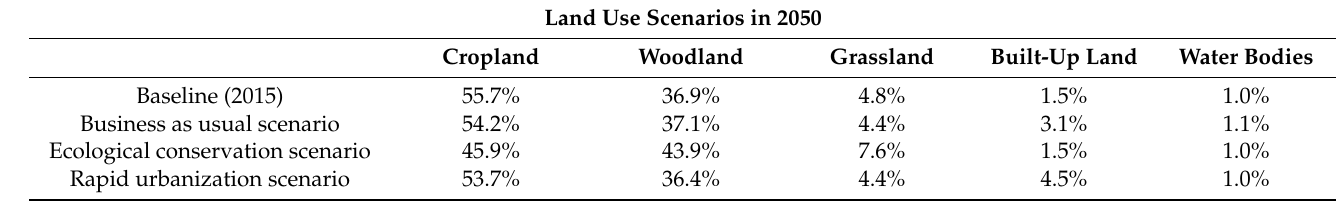
Table 3. Percentage of land use types under three scenarios.